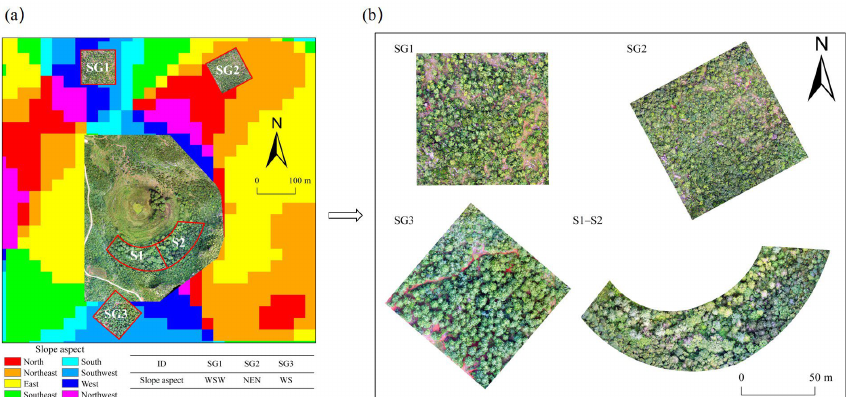
Figure 2. A schematic map of the samples. ( a ) Location map of tiankeng samples. Red border lines are samples. S1 and S2 are samples inside the tiankeng. SG1–SG3 are samples outside the tiankeng. WSW means the west-southwest slope, NEN means the north-northeast slope, and WS means the southwest slope. ( b ) Samples of tiankeng-inside and tiankeng-outside.